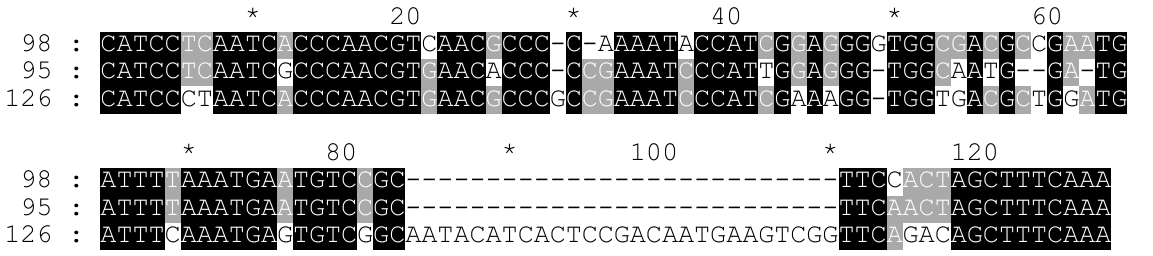
Figure 5. The alignment of the delCS ‐ 237 monomers from the 52978632nd–52979130th bp region of the WRXK01000002 contig.